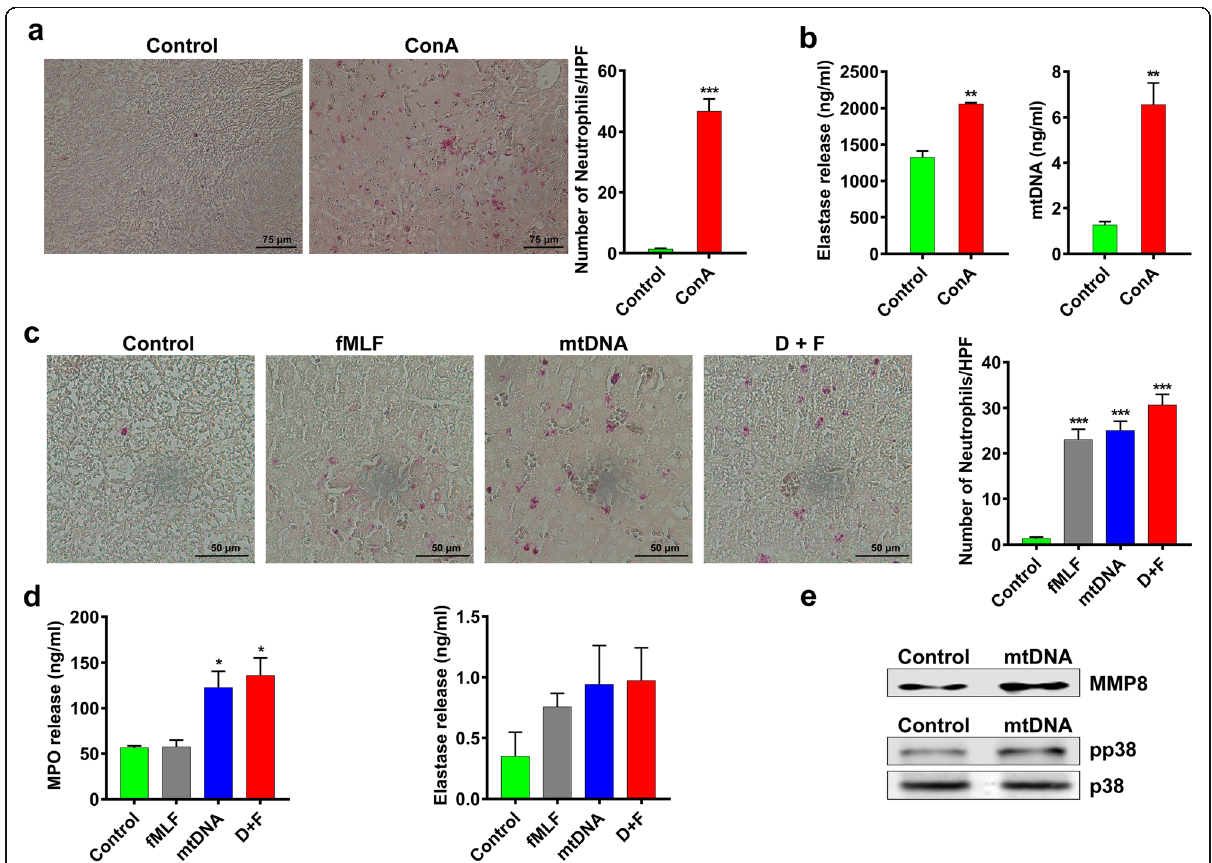
Fig. 4 ConA-induced acute liver injury in mice was mediated by mtDNA release after cell death. a A large number of esterase-positive neutrophils infiltrated in mice liver after ConA injection. b The serum level of elastase and mtDNA were increased after ConA injection. c The injection of fMLF, mtDNA, and D + F (mtDNA+fMLF) induced obvious neutrophils infiltration in mice liver. d The mtDNA and D + F induced MPO and elastase to release from neutrophils, while the fMLF showed a mild effect. e The mtDNA promoted the secretion of matrix metalloproteinase-8 (MMP-8) from neutrophils and caused the activation of p38-MAPK pathway. ( *p < 0.05, **p < 0.01, ***p < 0.001